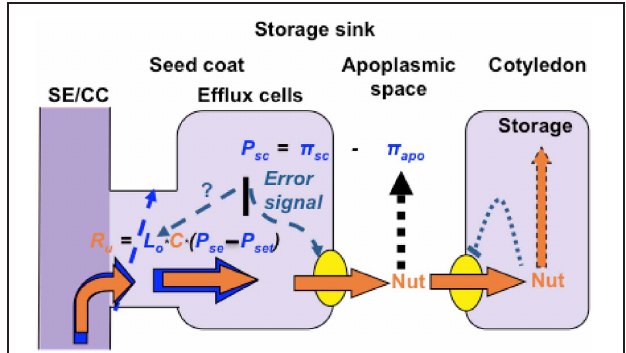
FIGURE 2 | Model of a high resistance pathway encountered by resource flow from transport phloem (green) into meristematic sinks through protophloem SEs differentiating from provascular cells (khaki) arranged in series with symplasmic movement through plasmodesmata of meristematic cells (brown). One tier of sink control of resource import is mediated by phytohormones integrating hydraulic conductances of this transport pathway with sink demand as illustrated for indole-3-actic acid (IAA), gibberellic acid (GA 3 ) and cytokinins (Cytks). During differentiation, each developing SE forms a large central vacuole (blue) and conspicuous protein bodies and plastids (red). Their vacuole and nucleus (purple) finally degrade to leave a parietal cytoplasm of protein bodies and plastids. Co-incidentally pit fields of plasmodemata coalesce into sieve pores.